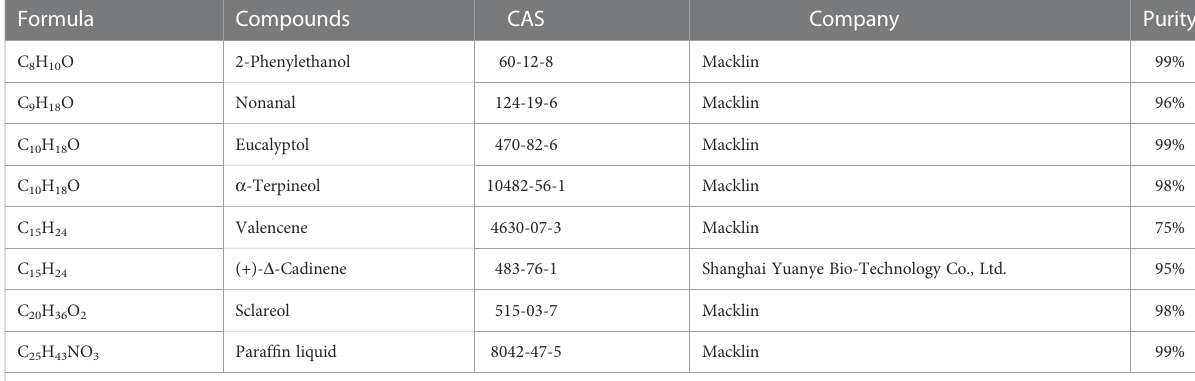
TABLE 1 Test compounds and their